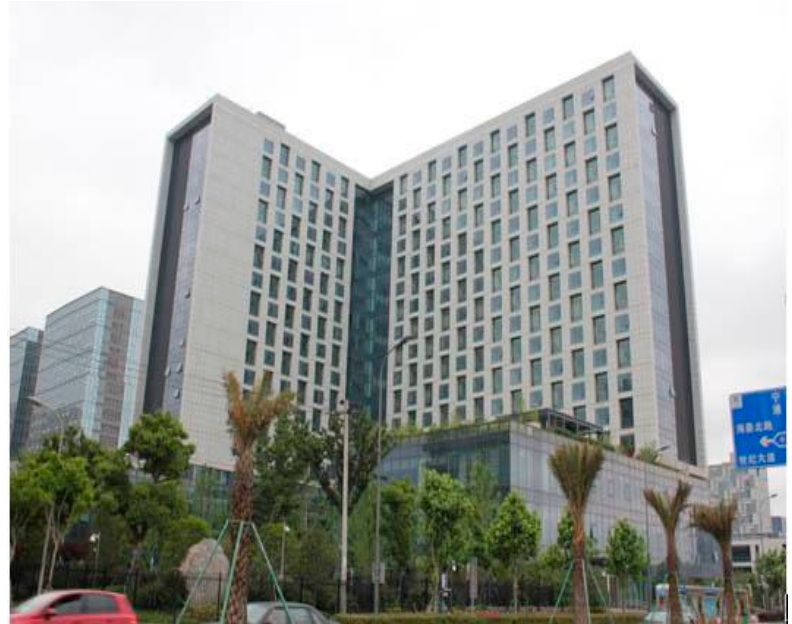
Figure 2. A government office building in Ningbo.